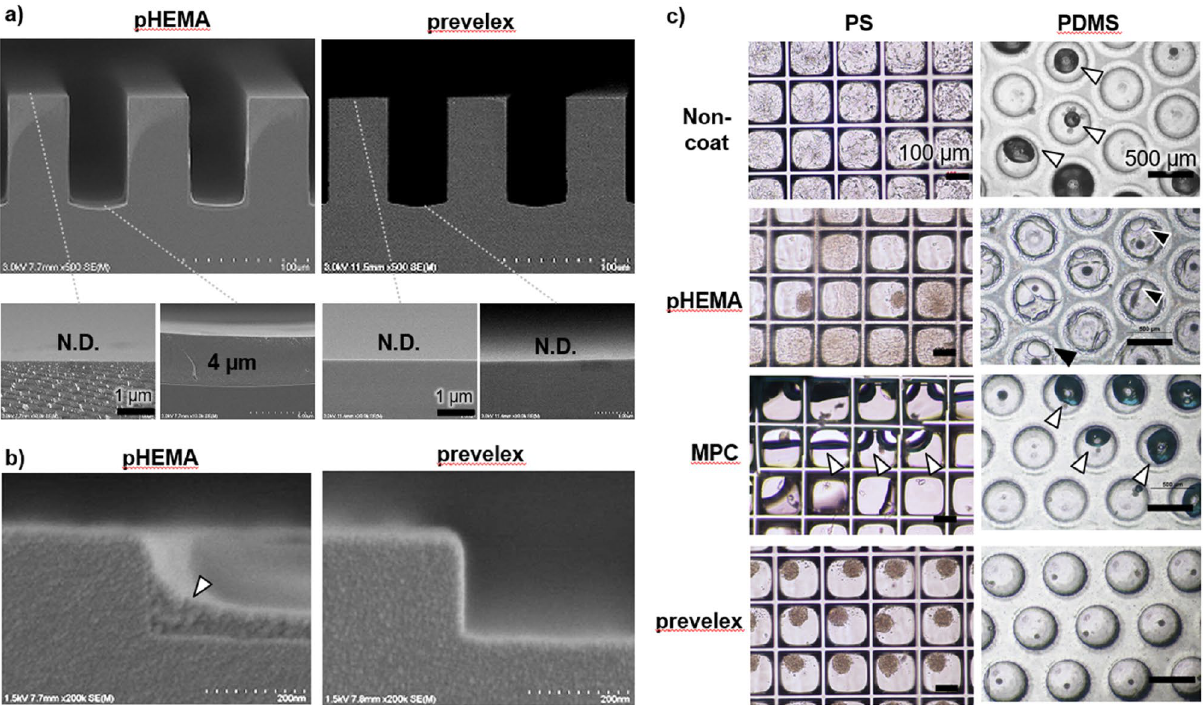
Figure 4. Prevelex coating to microstructures. ( a ) Scanning electron microscopic images of prevelex and 3.6% pHEMA layers coated on microstructured silicon substrates. ( b ) Coating on sub-micrometer stepped surfaces. Height of the step is 200 nm. ( c ) Comparisons of coating agents on microwell array plates. PS and PDMS plates are coated with three different coating agents. Cells are observed four days after seeding. White and black arrowheads indicate air bubbles and deformed layers of coating resin,